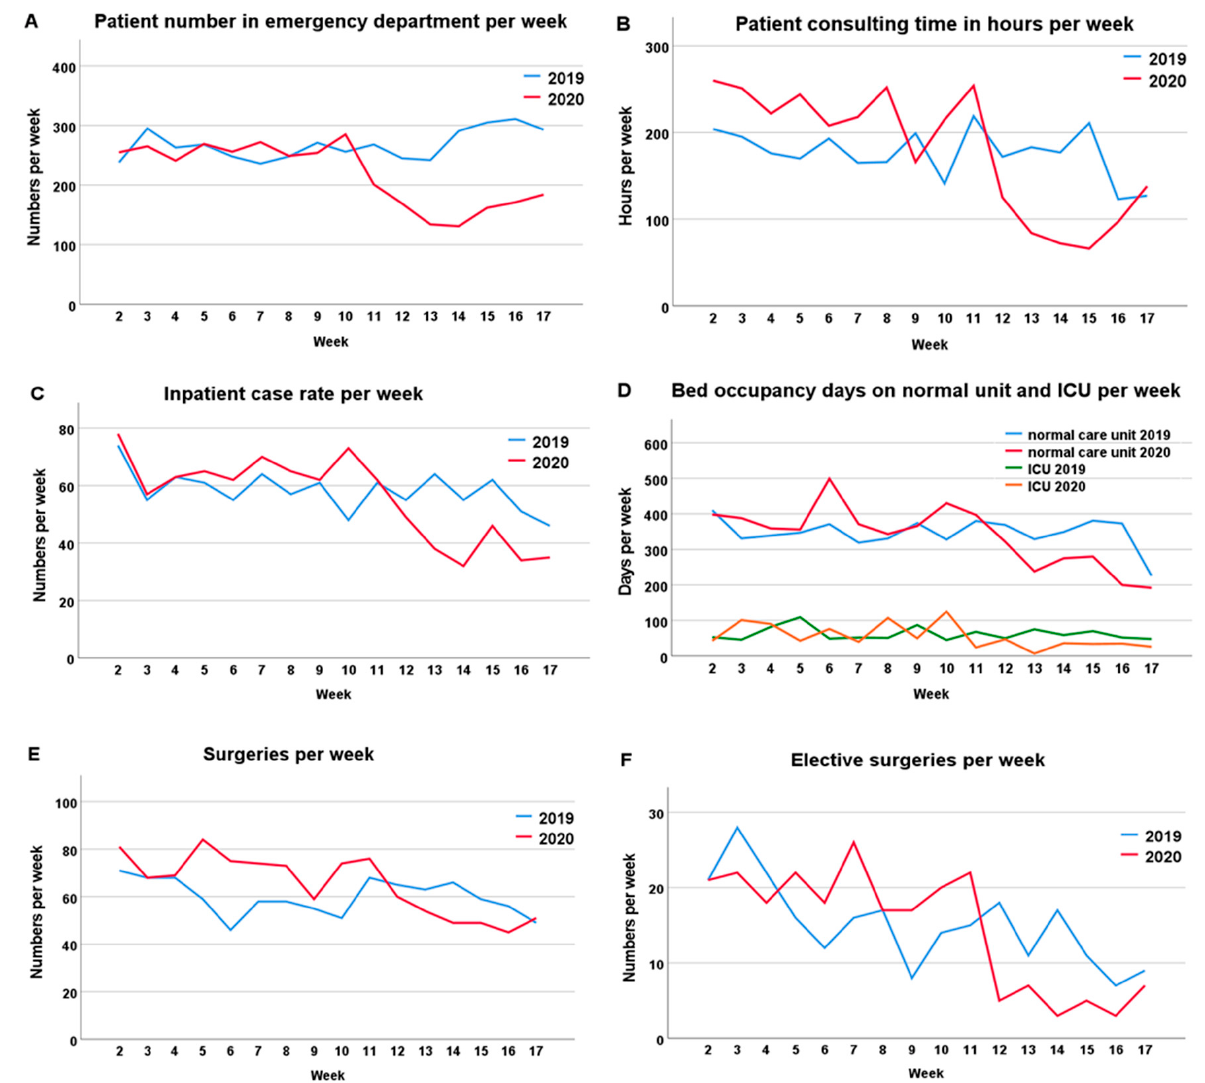
Figure 1. Time course of patient presentations, surgeries, and inpatient case numbers. The data of the 2nd to 17th weeks in 2019 (blue) and in 2020 (red) were compared. From the 11th week onwards, a decrease in case numbers could be detected, which could be attributed to the COVID-19 pandemic. ( A ) Patient numbers in the emergency department per week; ( B ) Patients consulting hours per week; ( C ) Stationary case rates per week; ( D ) Bed occupancy days on the normal and intensive care units per week; ( E ) Number of surgeries per week; ( F ) Number of elective surgeries per week. Table 1. Descriptive statistics of the investigated consultations and cases with mean ± standard deviation, 95% confidence interval, and p -values of weeks 02–10 vs. weeks 11–17 of 2019 and 2020. Statistical difference of the non-paired and non- parametric values was determined by the Mann–Whitney U test. In addition, the difference in the mean values between weeks 02–10 vs. weeks 11–17 was determined as ∆ (%) of W02–W10.